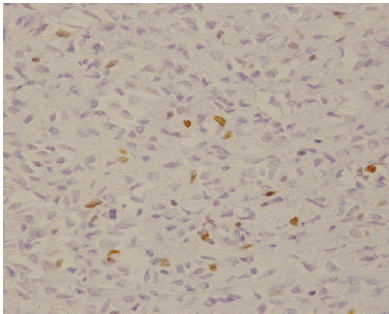
Figure 5: Ki-67 staining of the specimen resected in 1995. There are few Ki-67 positive cells. Ki-67 labeling index was 7 to 8%.